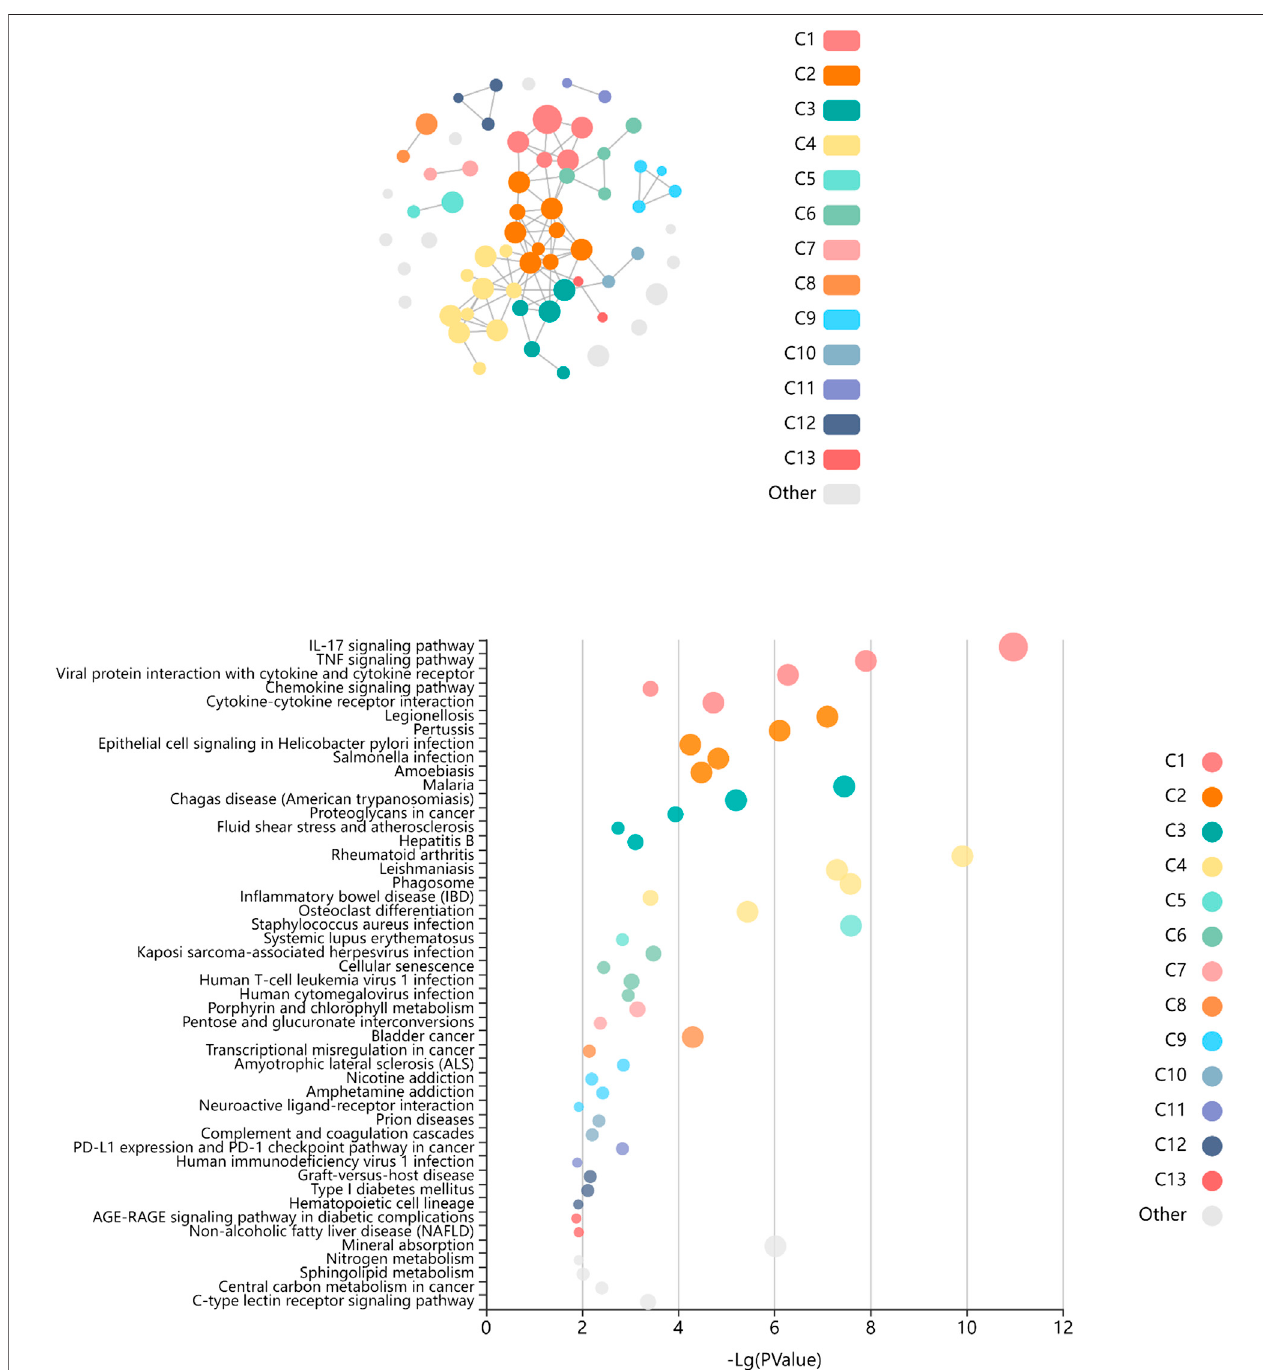
FIGURE2| EnrichedpathwaysofKEGGdatabaseassociatedtodifferentiallyexpressedgenesbetweenLGMDD2patientsandhealthycontrols.Eachnodeofthe networkrepresentsanenrichedterm,thenodecolorrepresentsdifferentclusters,andthenodesizerepresent5levelsofFDR-correctedp-values( p < 0.05, p < 0.01, p < 0.001, p < 0.0001 and p < 0.00001). The FDR-corrected p-value associated to each speci fi c KEGG pathway is showed in the bubble plot.